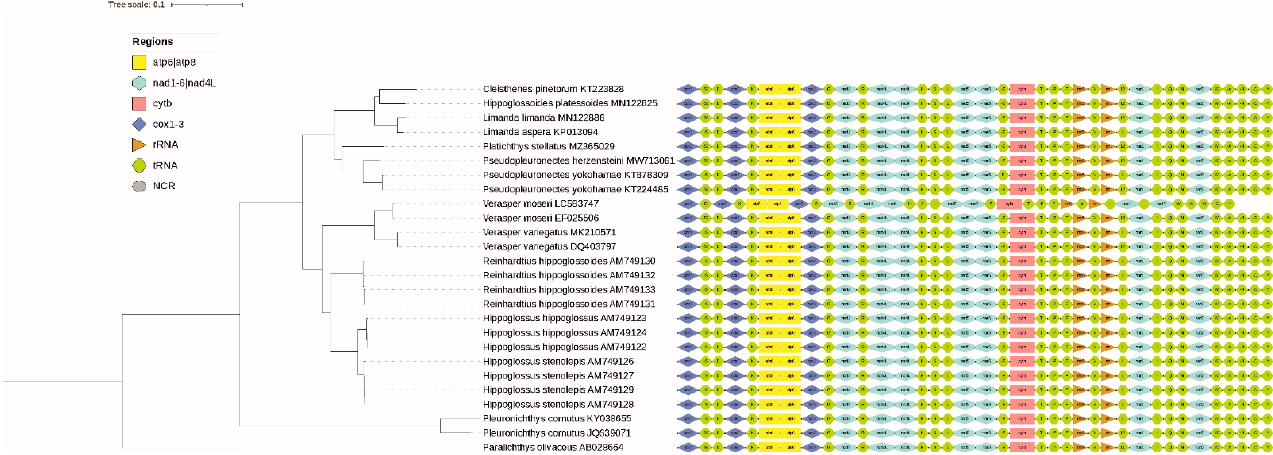
Figure 2. A map of the mitogenomes in linear mode for the 26 species of flounder of the family Pleuronectidae along with BA-tree. For simplicity, CRs are excluded from the comparison because of their variable numbers in flounders’ mitogenomes. Details of the phylogenetic reconstruction and tree topology will be presented in the next sections. Probabilities for all nodes in the gene tree that are depicted on the left are equal to 1.0 for all interspecies branches. The number of generations simulated in this case is equal to n = 2 × 10 6 .